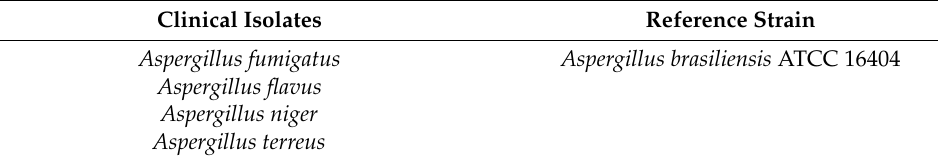
Table 1. The Aspergillus strains used in this